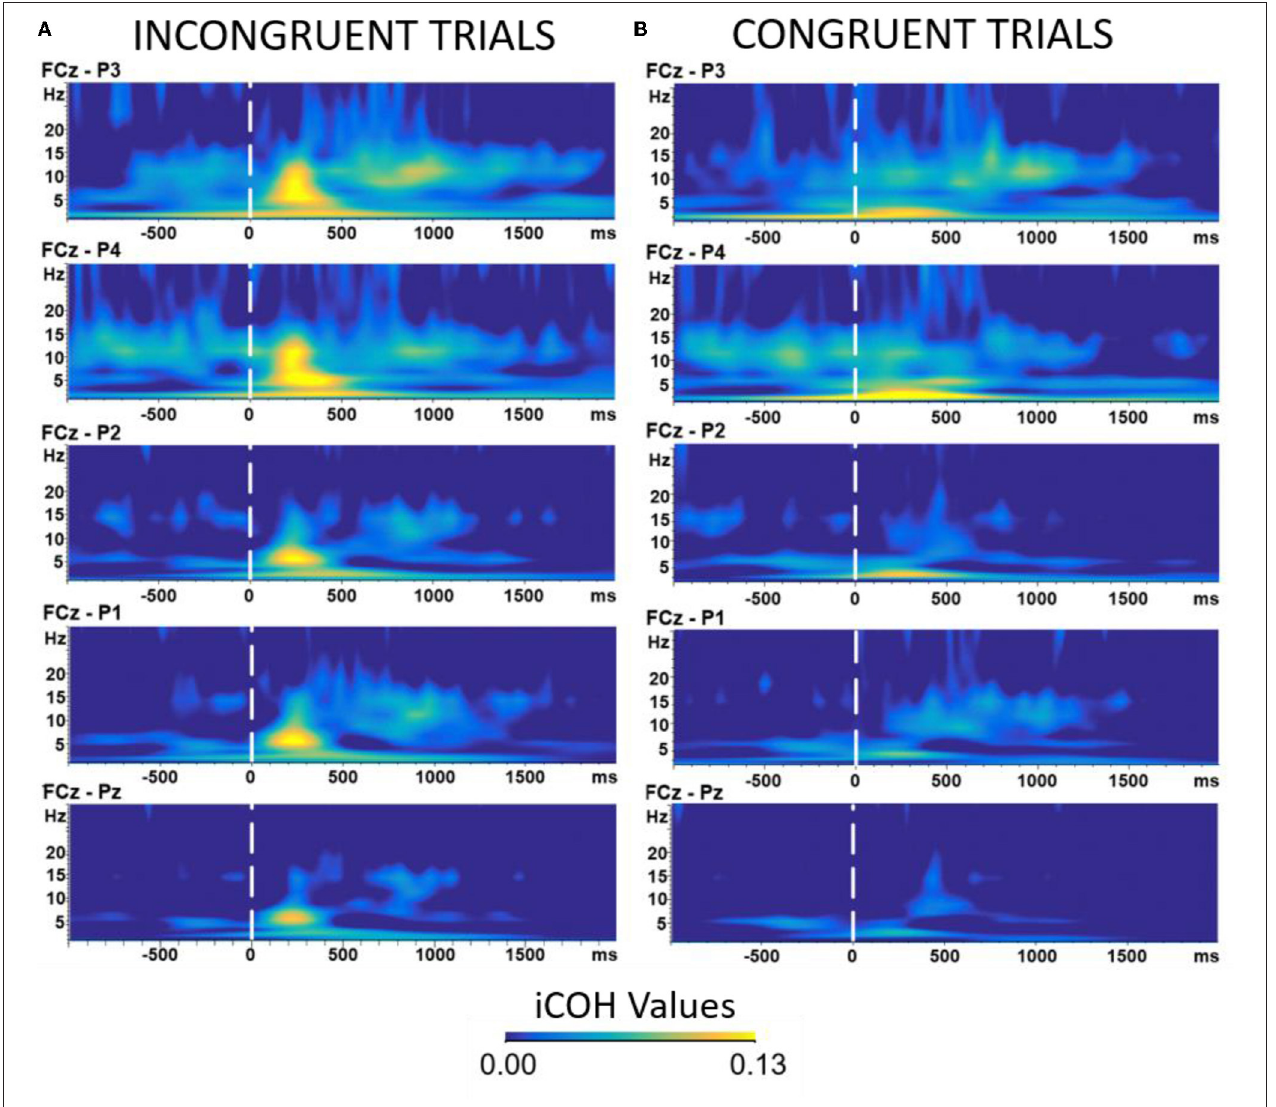
FIGURE 4 | Time-frequency analysis of EEG data comparing Incongruent (A) vs. Congruent (B) trials. The epochs were all timelocked to the onset of the robot head cue. Warmer colors represent higher coherence values among the selected electrodes (see EEG acquisition and preprocessing section). The Y axis represents the frequency (measured in Hz). The X axis represents time measured in milliseconds. All results were time locked to the onset of robot’s head signal. Results of the analysis showed a difference in amplitudes in the theta frequency band (3–7Hz) at around